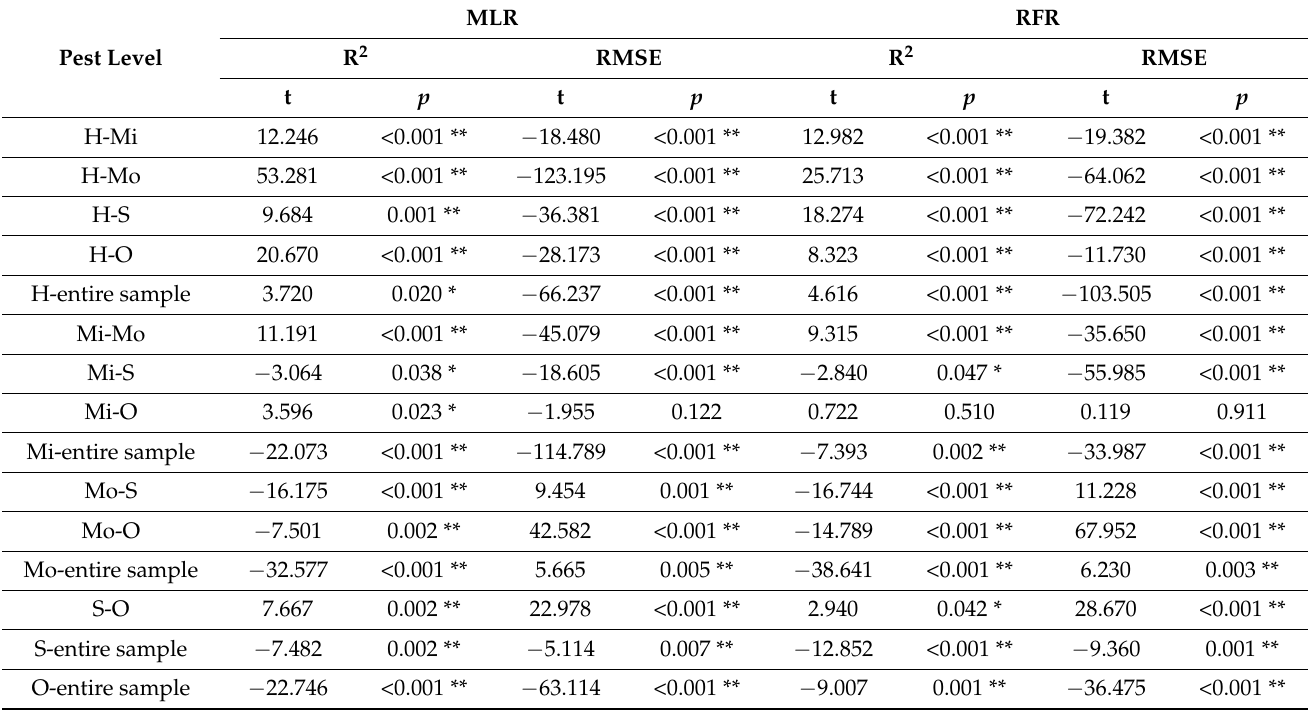
Table 4. Paired t -test of LWC estimation indices for leaves from the entire sample and leaves with different damage levels.